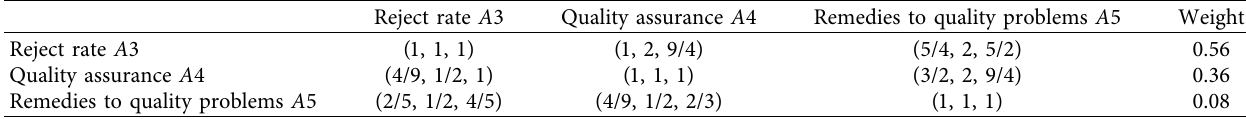
Table 4: Fuzzy judgment matrix of product quality.